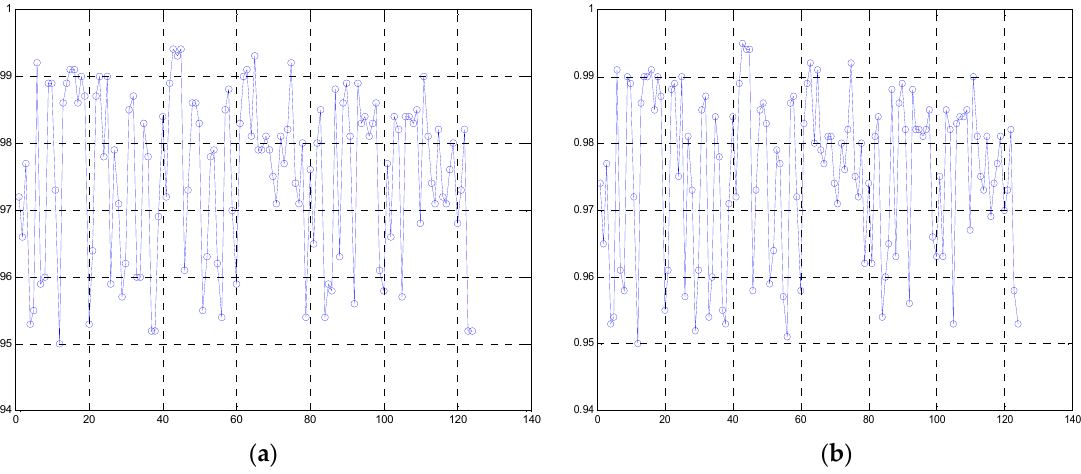
Figure 10. Coherence coefficient of the tie-points in the master and slave SAR images within strips, where ( a ) is the master image and ( b ) is the slave image.